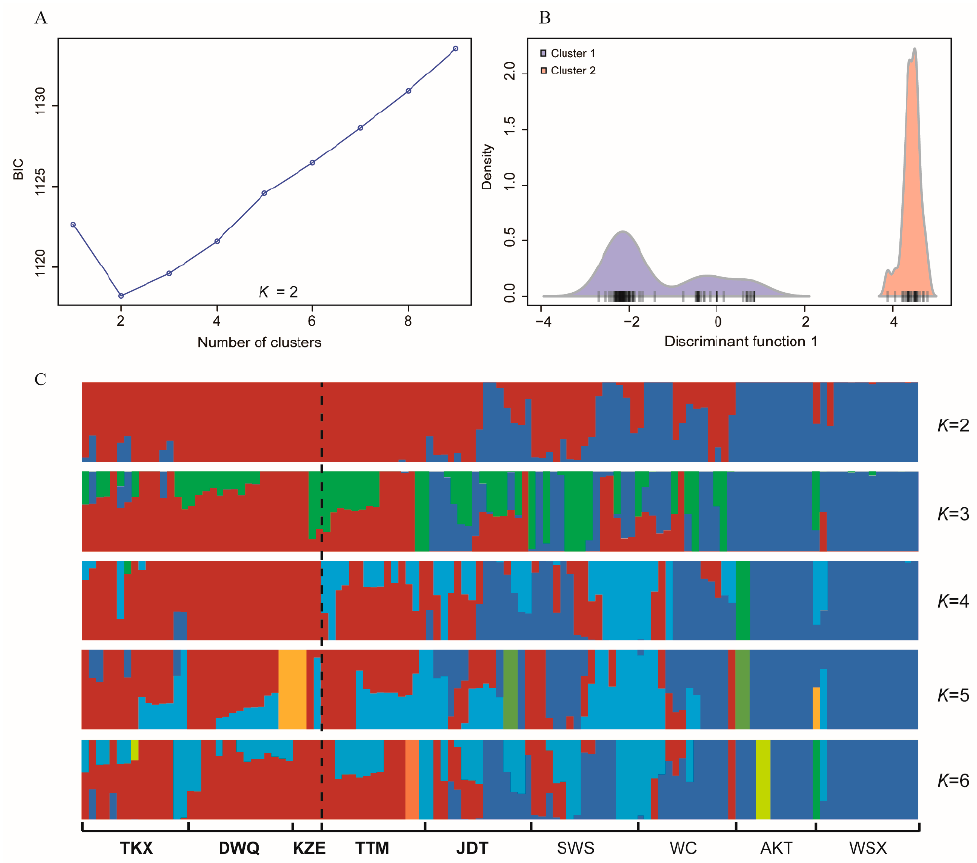
Figure 2. The distribution of BIC values with number of clusters ranged from 1 to 9 ( A ) and the densities of individuals on a given discriminant function for two clusters ( B ); the admixture clustering results for K = 2~6 with Bayesian analysis using fastStructure based on the filtered dataset ( C ). The dashed line represents the separation of south and north populations.